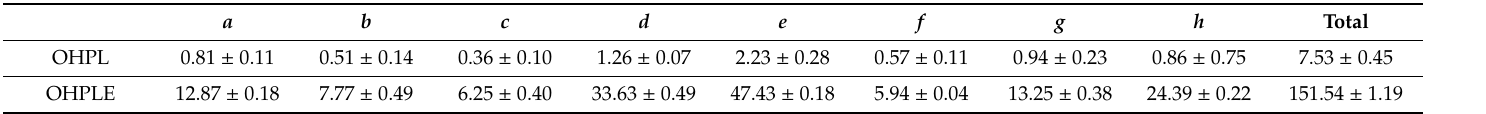
Table 2. Quantitative analysis of the dominant compounds in OHPL and OHPLE (mg /